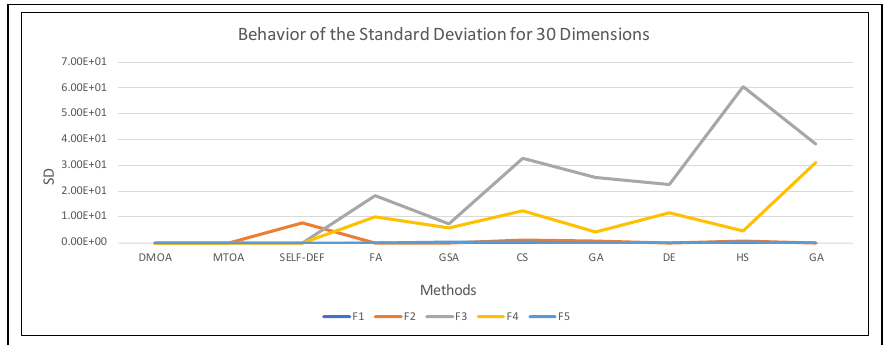
Figure 12. Behavior of the Standard Deviation of the DMOA Algorithm and the methods: MTOA, Self Defense, FA (FireFly Algorithm, GSA, CS, GA, DE, HS, and GA for 30 dimensions.